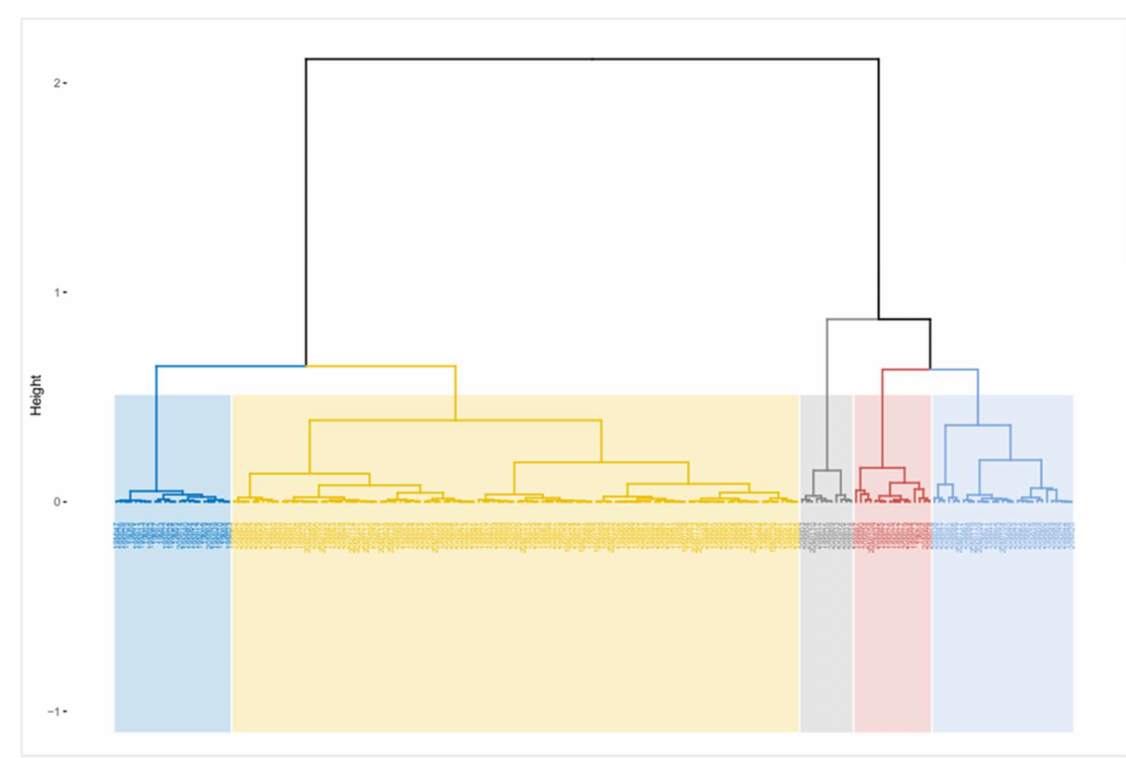
Figure 3. Cluster dendrogram. The blue group is represented by honeys from the province of Chilo é (75%), by TPV honeys (17%), and by honeys from the Los R í os Region (only 4.2%). Additionally, said group is mainly made up by multifloral honeys (63%), Ulmo (20%), and—in smaller amounts—by species such as Fabaceae, Tineo, and